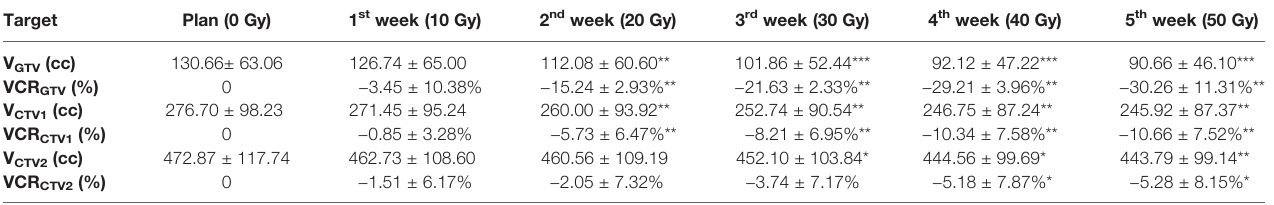
All were compared with plan levels. *P < 0.05, **P < 0.01, ***P < 0.001, using Wilcoxon signed-rank test.